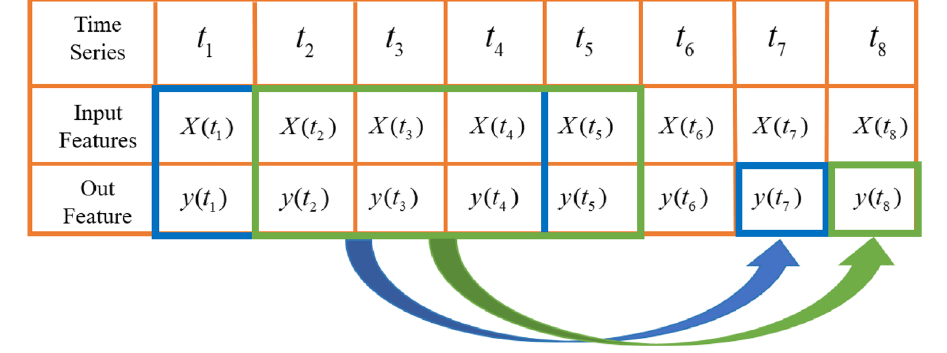
Fig. 8 An example of General Autoregression